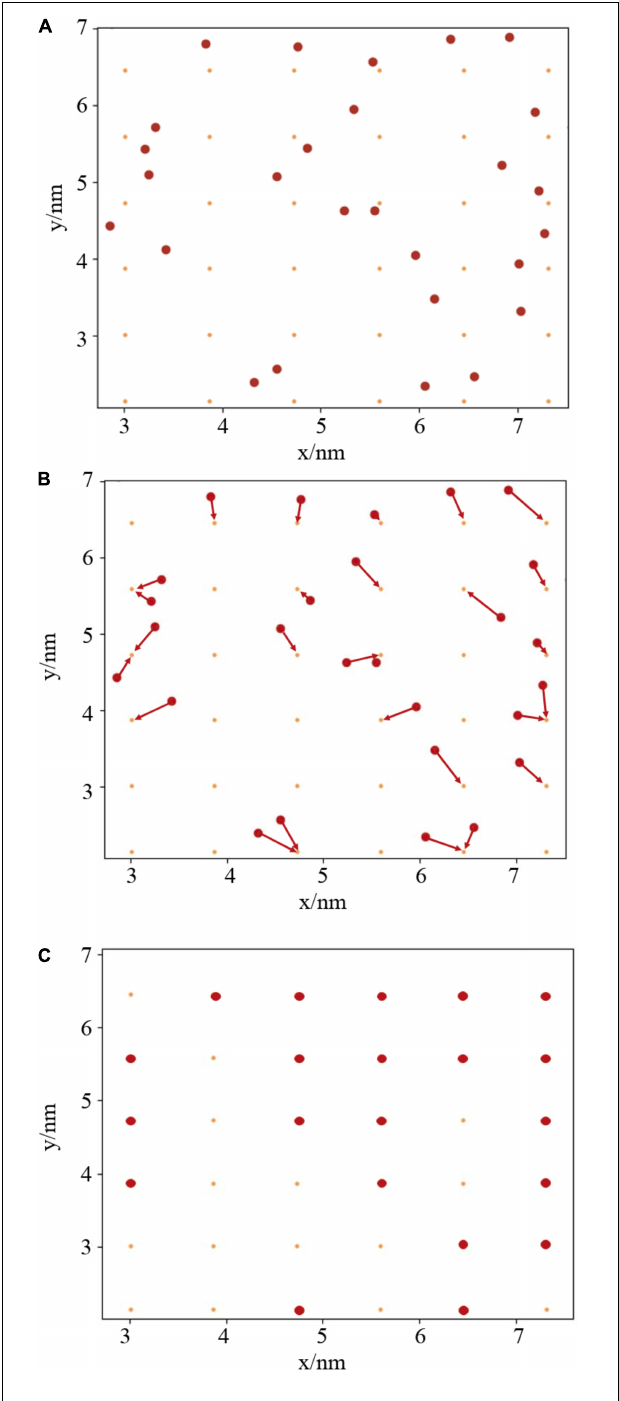
FIGURE 2 | (A) Two dimensional projection of lipid atoms and grid points. (B) Rounding of atoms to nearest grid points. (C) Calculation of total pore area as the proportion of unoccupied (orange) to occupied (red) grid